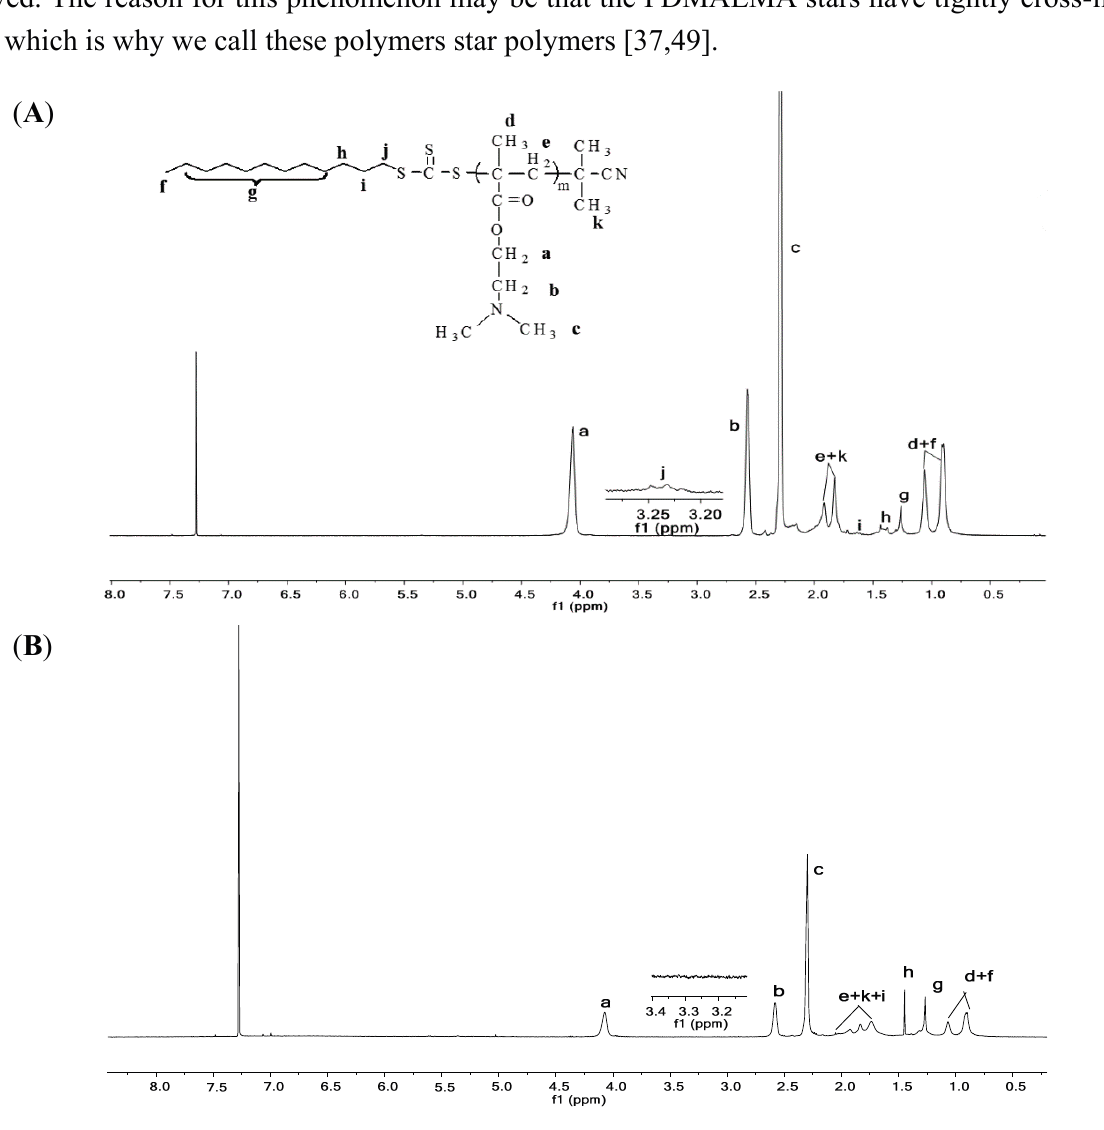
Figure 5. 1 H NMR spectra of PDMAEMA-CPTCD ( A ) and SPDMAEMA-8 ( B